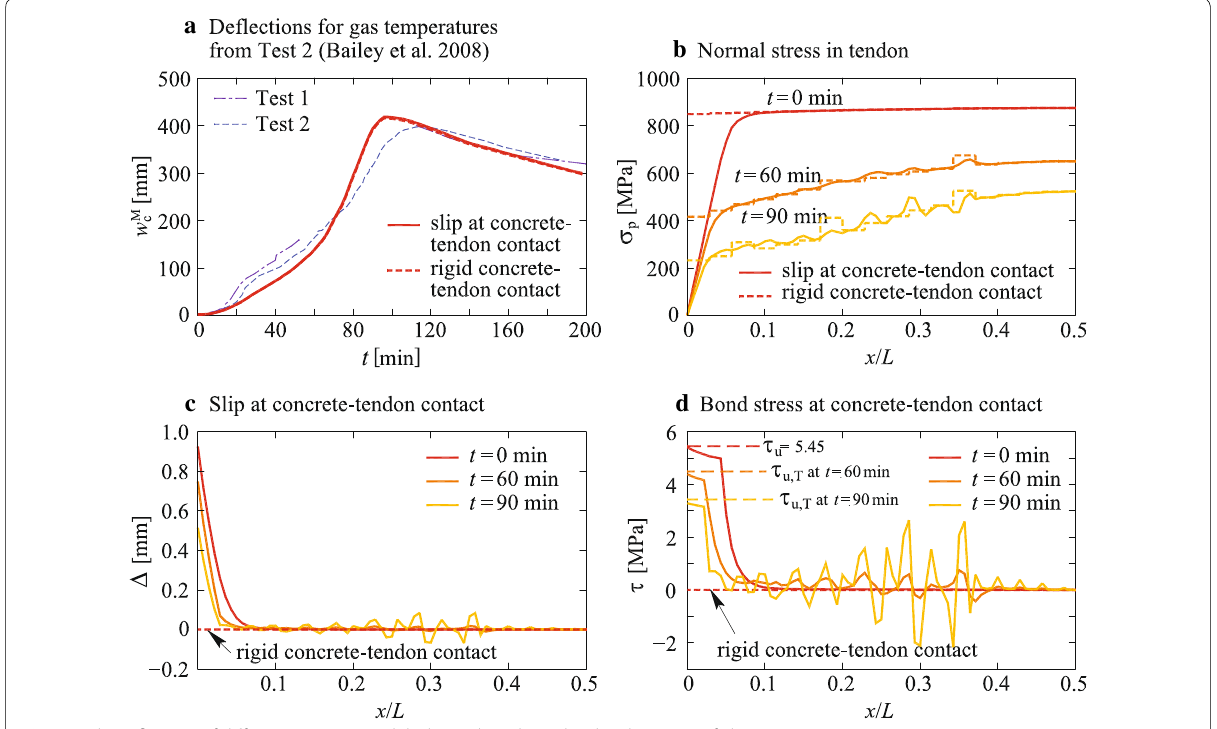
Fig. 14 The influence of different contact model (slip and rigid) on the development of chosen quantities.